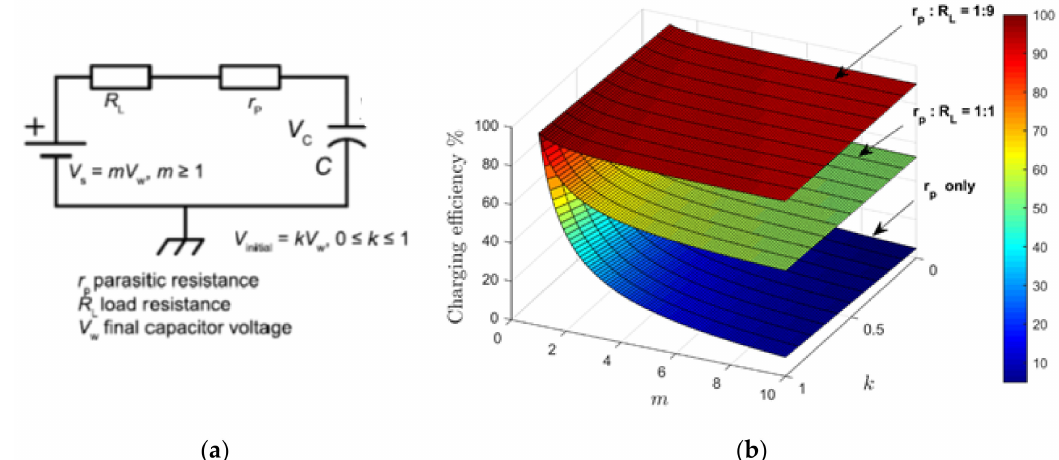
Figure 4. Insertion of a useful resistive load into the partially charging RC loop: ( a ) modified circuit with useful resistance R L ( b ) Graphical representation of the circuit behaviour in terms of efficiency versus variables m and